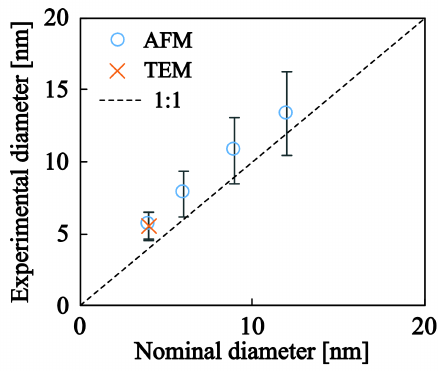
Figure 4. Experimental versus nominal NP diameters for a series of Ag nanoparticle depositions. Experimental diameters were obtained from AFM and TEM images after digital image